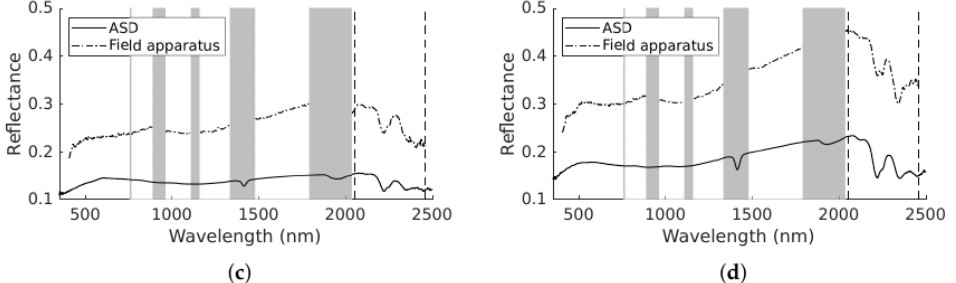
Figure 4. Sample spectra scanned with the Analytical Spectral Devices, Inc. (ASD) TerraSpec FR and the spectral pixel from the scene scanned by the field apparatus corresponding to the approximate location from which the sample was taken. The grey bands represent regions where there is significant atmospheric absorption and data have been removed. The dashed lines at 2050 and 2460nm show the bounds of the spectral region that was used for classification. ( a ) <0.01 ppm. ( b ) 0.17 ppm.